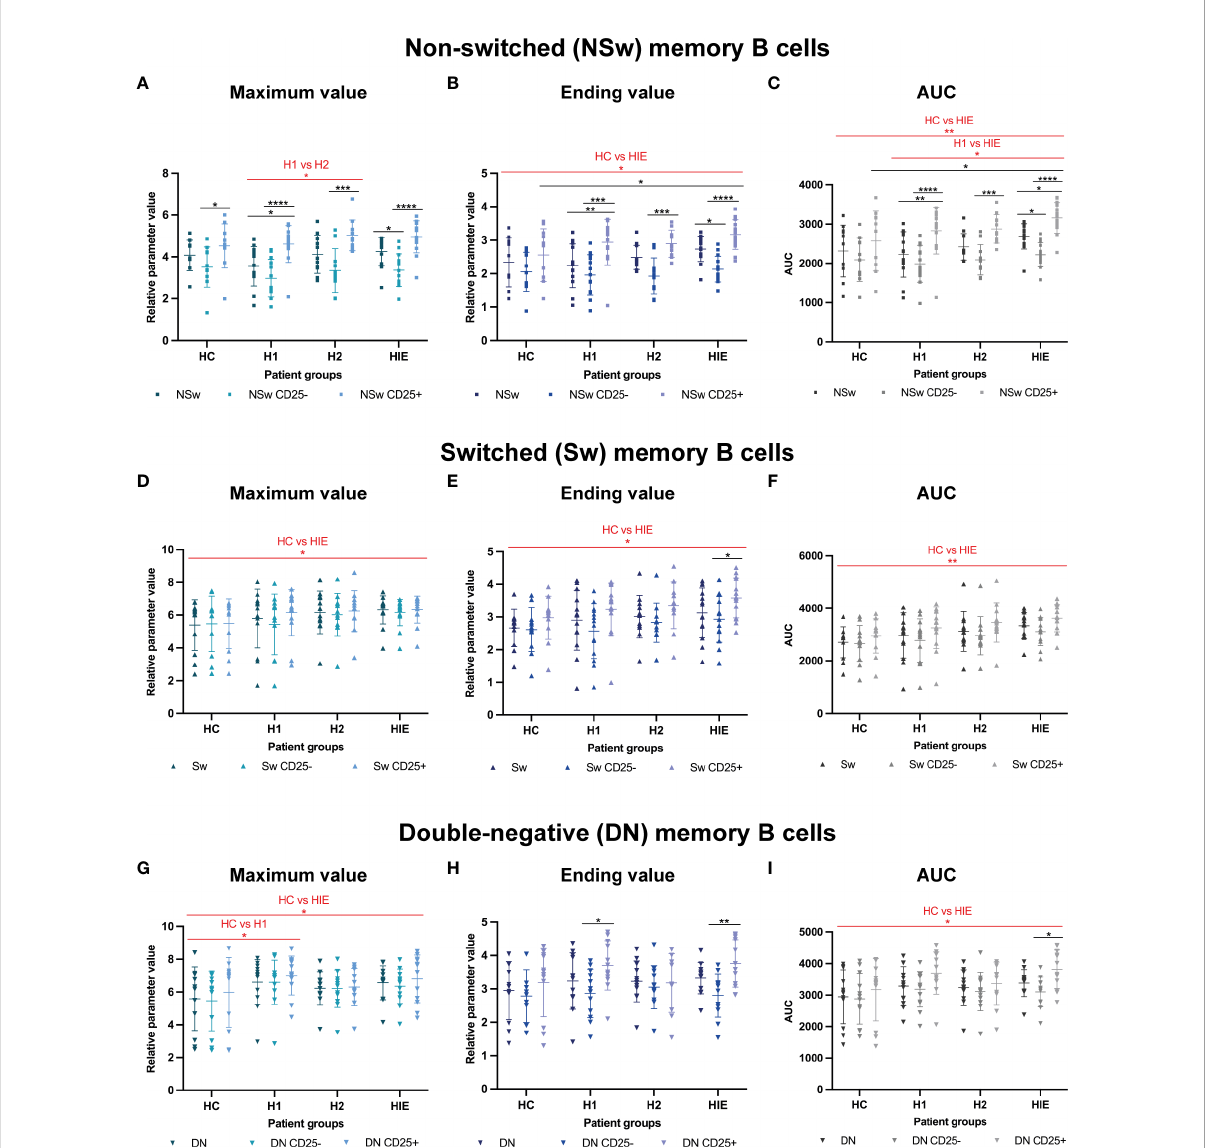
FIGURE 5 Memory B cells of ATA+, euthyroid, infertile patients have increased calcium fl ux upon BCR activation Selected calcium fl ux kinetic data of memory B cell subsets: Non-switched (NSw) memory B cells, CD25- and CD25+ NSw cells: (A) maximum value, (B) ending value, (C) area under curve (AUC) value. Immunoglobulin class-switched (Sw) memory B cells, CD25- and CD25+ Sw cells: (D) maximum value, (E) ending value, (F) area under curve (AUC) value. CD27-, IgD- double-negative (DN) memory B cells, CD25- and CD25+ DN cells: (G) maximum value, (H) ending value, (I) area under curve (AUC) value. HC: healthy controls (n=12); HT: Hashimoto ’ s thyroiditis, H1: hypothyroid patients with HT before treatment (n=14); H2: euthyroid patients with HT, after levothyroxine-treatment, (n=12); HIE: HT, infertile, euthyroid patients (n=14).